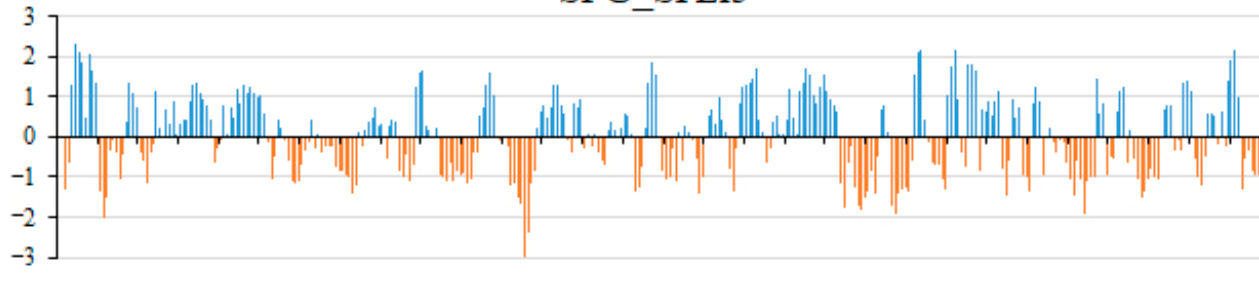
Figure 2. Monthly rainfall and mean, minimum, and maximum temperatures for the entire trial period at San Piero a Grado (SPG), Pisa.